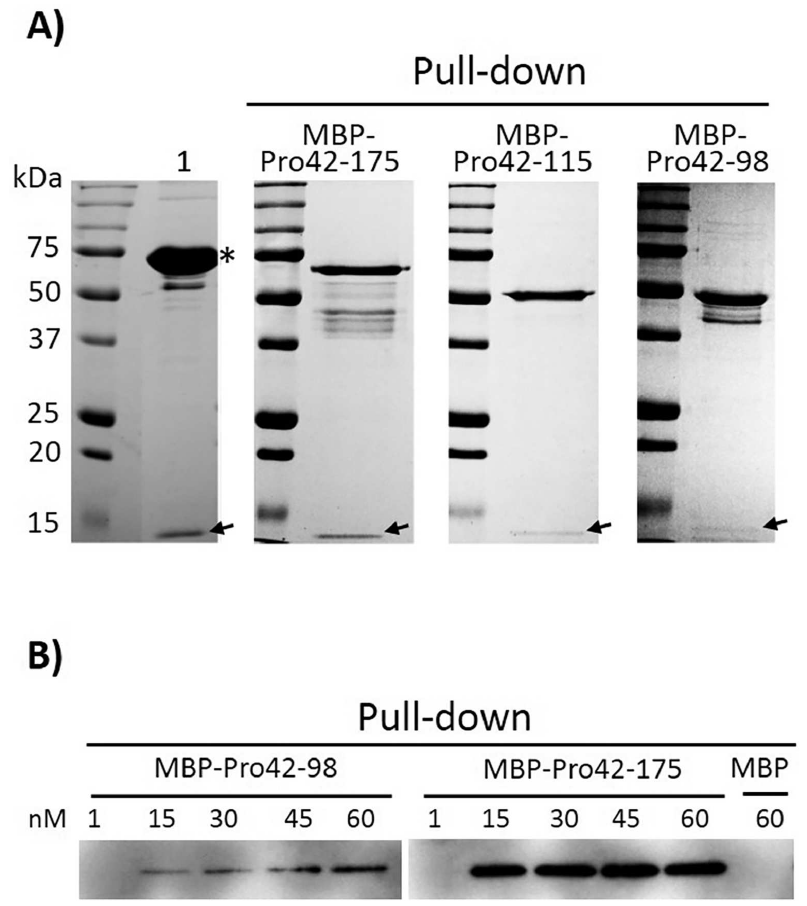
Fig 5. Binding of MBP-MSTNpro proteins to MSTN in a pull-down assay. A) Fifty microlitersof amylose resin was mixed with either 480 nM of MBP-Pro42-175, MBP-Pro42-115, or MBP-Pro42-98 plus 48 nM of MSTN, separatelyto a final volume of 1 mL pull-down assay. The column was then washedwith column buffer three times. Proteins bound to the amylose resin were then eluted with reducing SDS-PAGE loading buffer, and subjectedto SDS-PAGE analysis. The commercial MSTN (lane 1) added in the pull-down experiment containedabout 50-fold excess amount of BSA ( * ) as a carrier protein (R&D Systems). Arrows indicateMSTN bands. B) The same procedure describein A was employedexcept that five different concentrations (1, 15, 30, 45, 60 nM) of either MBP-Pro42-175 or MBP-Pro42-98 with fixed concentration of MSTN (6 nM) were examinedin the pull-down experiment. MBP (60 nM) bindingto MSTN (6 nM) was also examinedin the pull-down assay to serve as a negativecontrol. Proteinsbound to the amylose resin were eluted and subjectedto immuno-blot analysisagainst monoclonal anti-MSTN antibody.